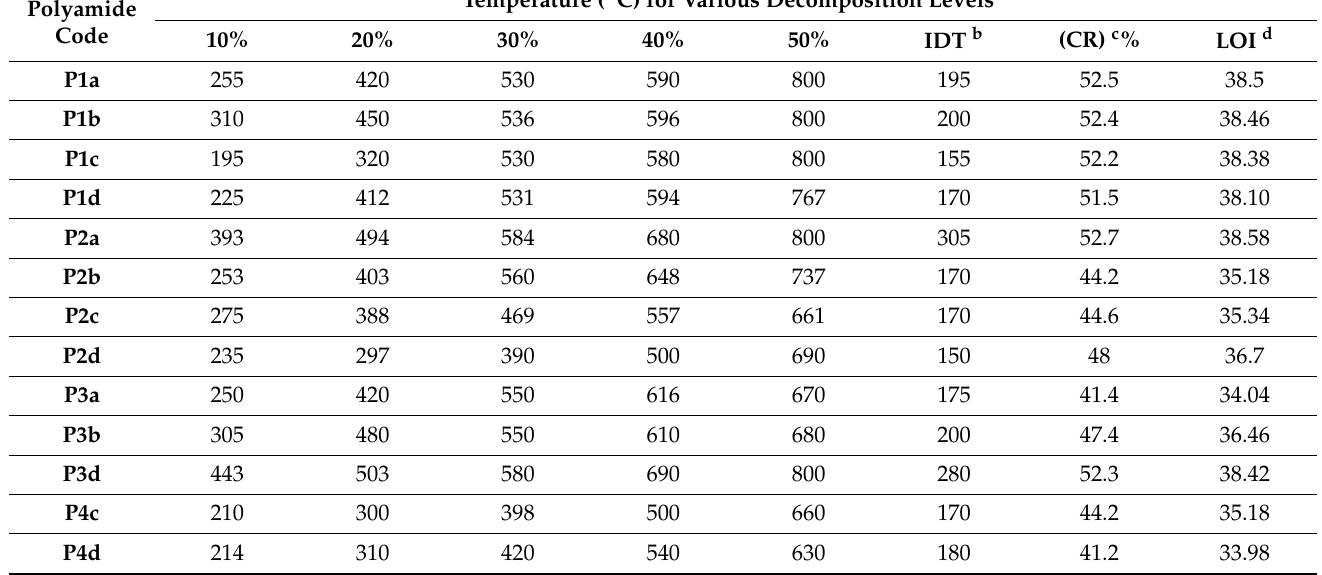
Table 2. Thermal properties of the polyamides P1a–d, P2a–d, P3a,b,d and P4c,d. Temperature ( ◦ C) for Various Decomposition Levels